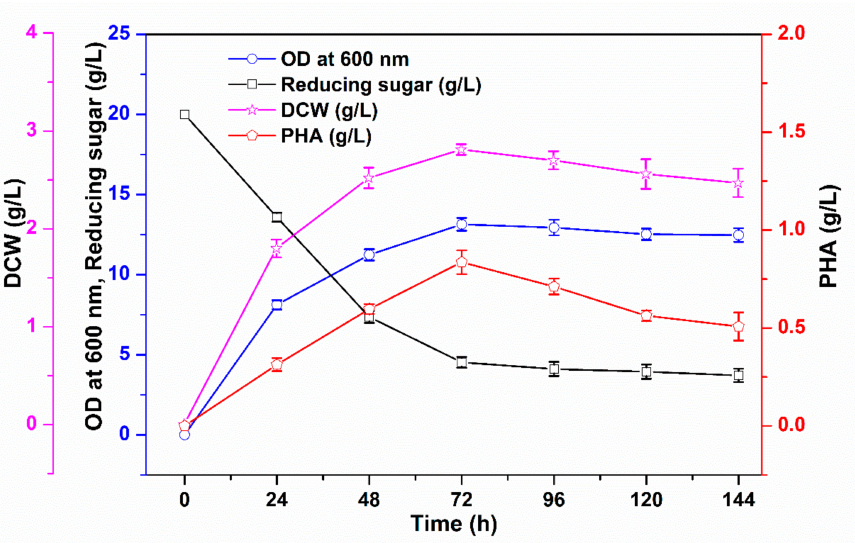
Figure 1. Time profile of optical density (OD) at 600 nm, dry cell weight (DCW), polyhydroxyalka- noate (PHA) accumulation, and substrate utilization by Bacillus megaterium ALA2 using 0.3 N HCl defatted Chlorella biomass (DCB) hydrolysate as the carbon source in a flask culture. Data are shown as mean values ± standard deviation ( n =